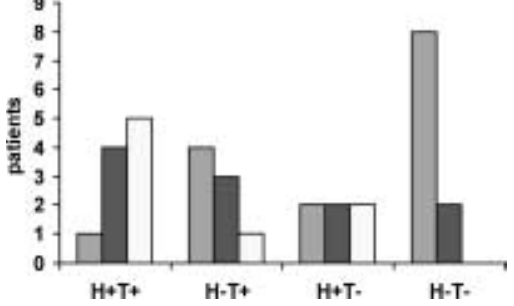
Fig. 2. Association between HPV positivity (H+) and telomerase activity (T+) in normal cervical epithelium (blue) and squamous intraepithelial lesions, low grade (LGSIL; red), and high grade (HGSIL; yellow). a history of LGSIL and HGSIL, respectively. Three